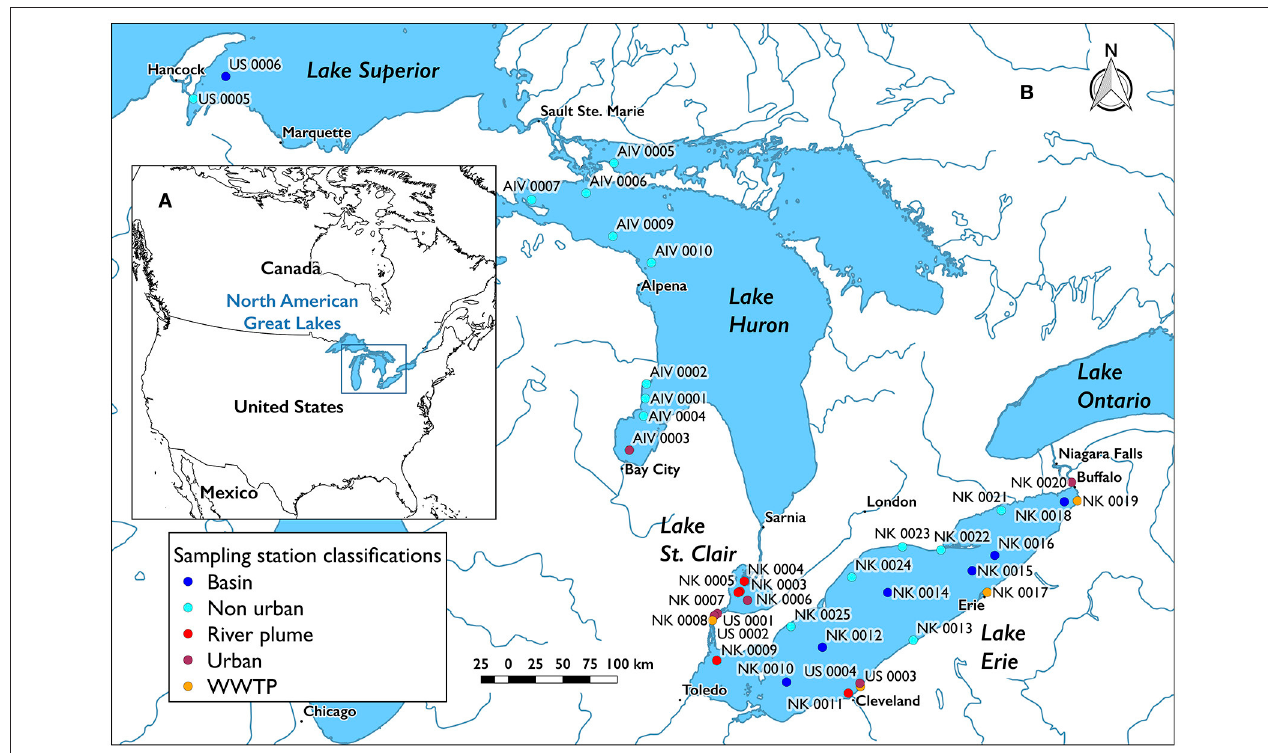
FIGURE 1 | Maps of all stations sampled. Each station contained replicate trawls. (A) Overview and location of the North American Great Lakes on the North American continent. (B) Station locations and classifications in Lake Superior, Lake Huron, Lake St. Clair, and Lake Erie.